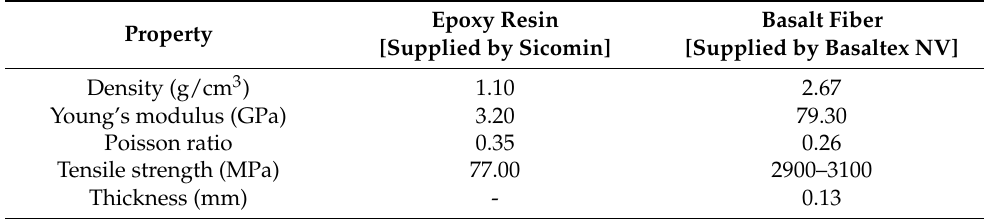
Table 3. Physical and mechanical properties of the starting materials (as mentioned by the supplier).